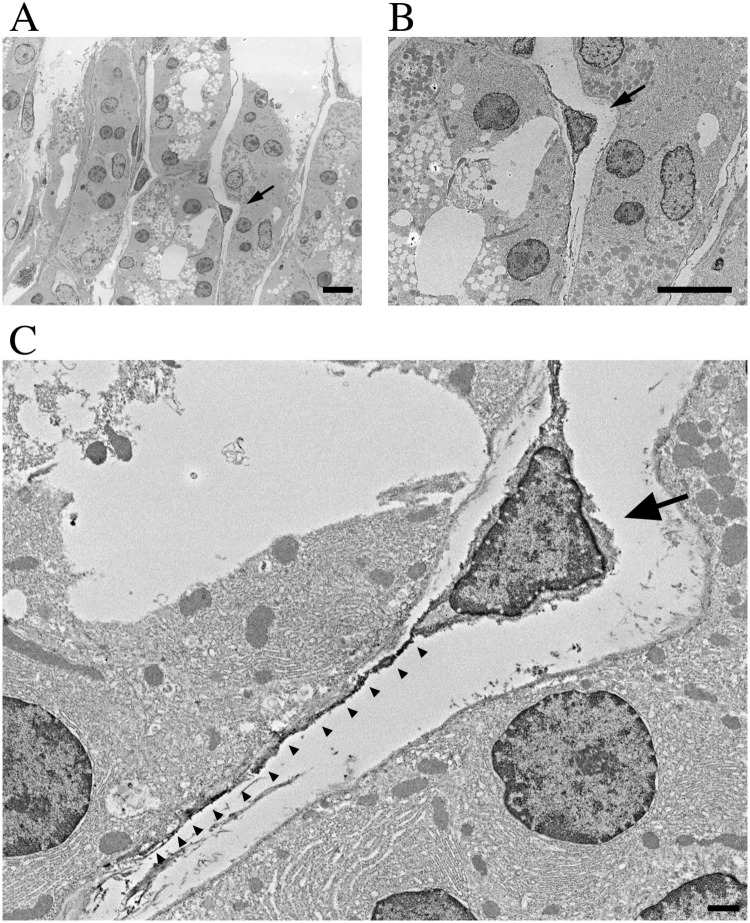
Identification of NG2+ telocytes in rat stomach using electron microscopy.(A-C) Representative electron micrograph of NG2-labeled gastric telocytes in the adult rat. (B-C) Magnified views of NG2 immunoreactive cell (arrow) in panel (A). (C) Arrowheads show cellular processes, stained with the anti-NG2 antibody. Scale bars: 10 μm (A-B) and 1 μm (C).